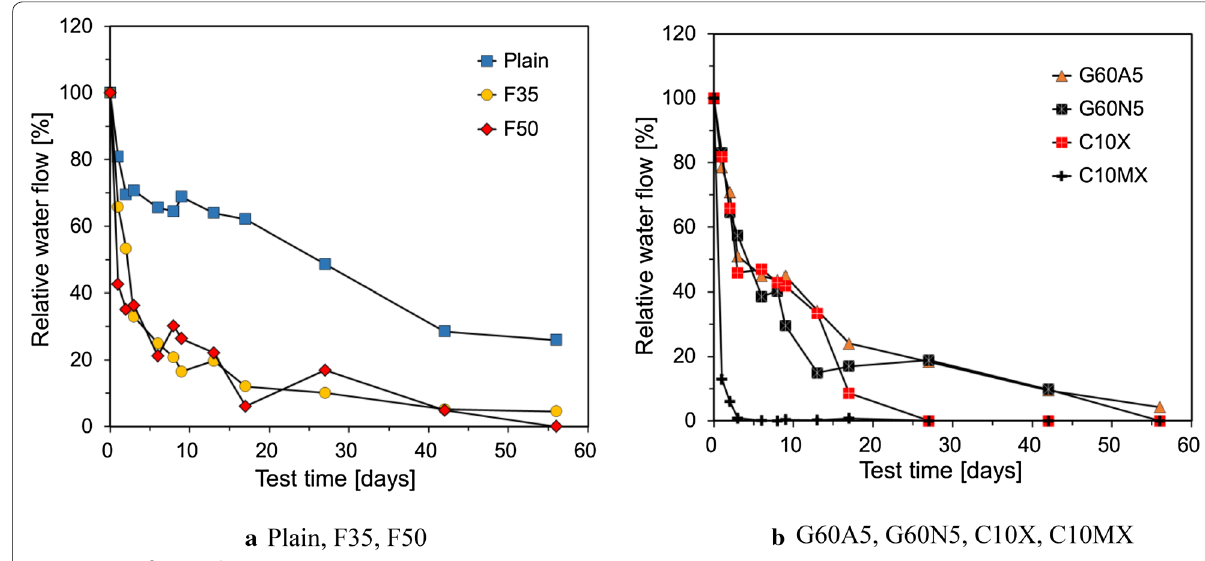
Fig. 10 Water flow